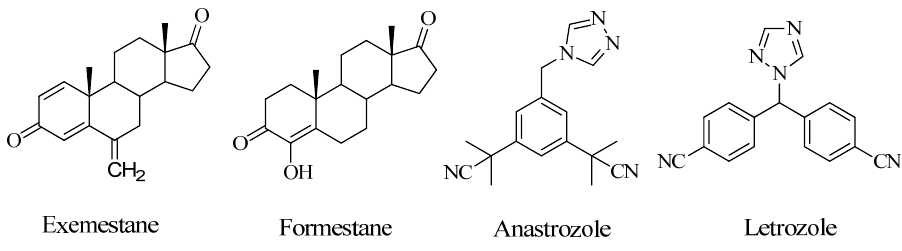
Figure 1. Chemical structures of known steroidal and nonsteroidal aromatase